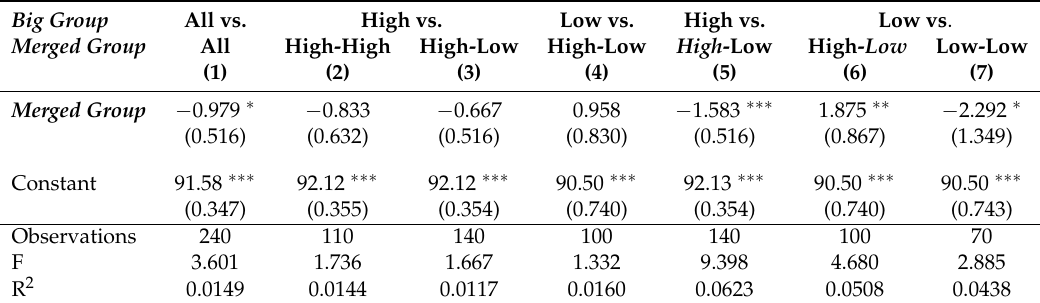
Table A5. Linear regressions: group payoffs in Part